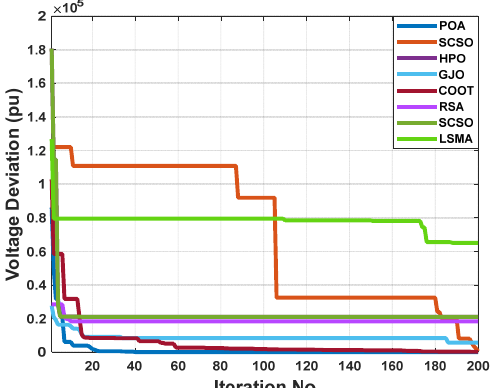
Figure 24. The voltage profile of the POA and other compared algorithms for case 3 in a standard IEEE 57-bus test system.